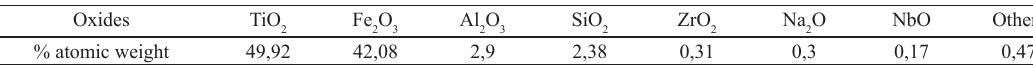
Table 3. Vibrational bands in infrared spectrum. Wavebands (cm -1 )